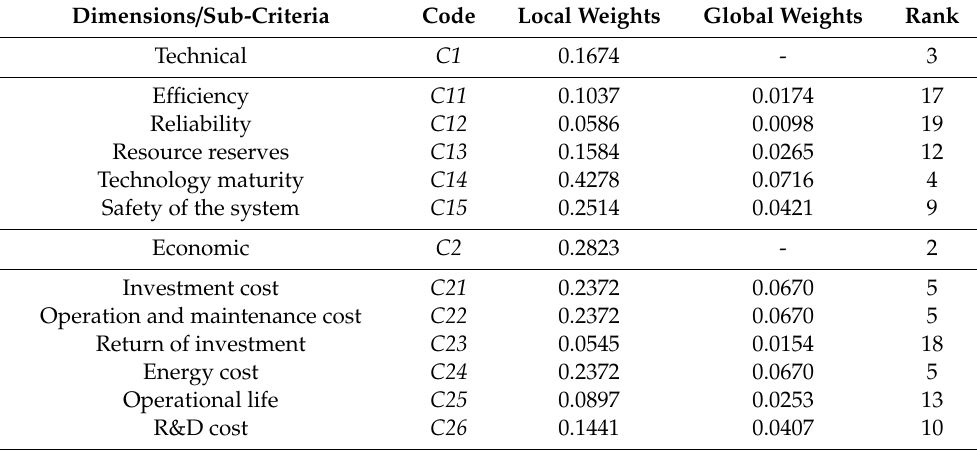
Table 4. The optimal values of the weight coe ffi cients of the dimensions / sub-criteria. Dimensions /